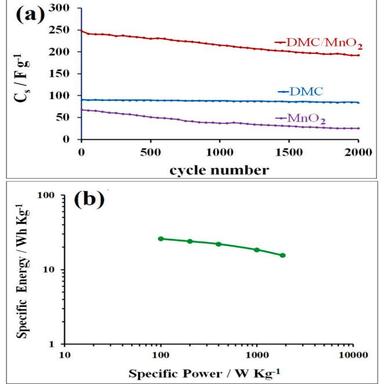
(a) Cycle-life data of DMC, MnO2 and DMC/MnO2 at current density of 2 A g−1, (b) The Ragone plot obtained for DMC/MnO2 symmetric supercapacitor.